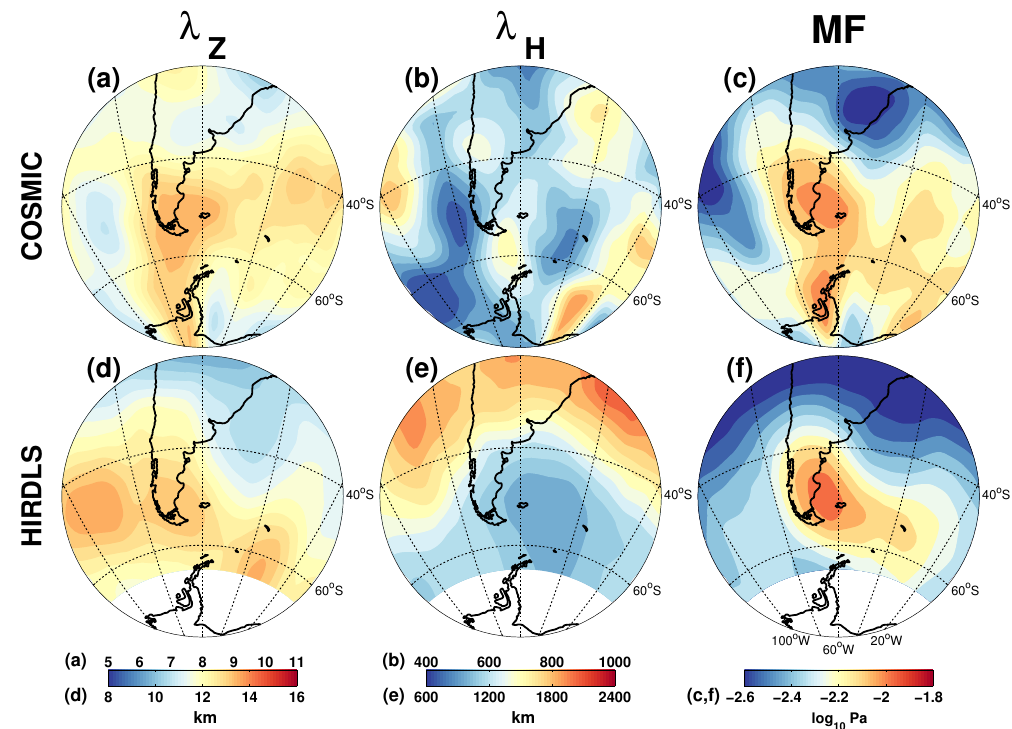
Figure 10. Orthographic projections of vertical wavelength λ Z , horizontal wavelength λ H and momentum flux (MF) for COSMIC ( a , b , c ) and HIRDLS ( d , e , f ) at 30km ( ∼ 10hPa) during June–August